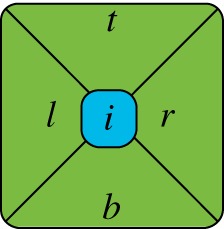
The Kari prototile. (Online version in colour.)